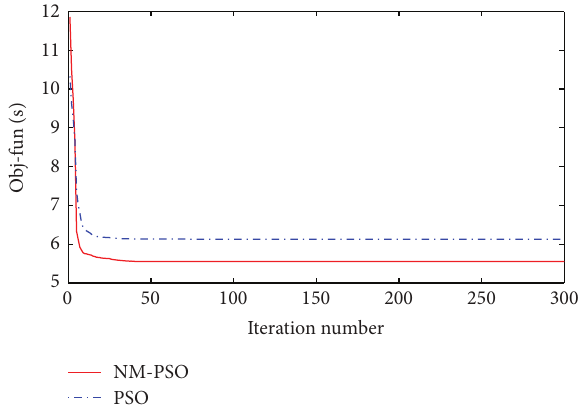
Figure 2: Convergence characteristics of a conventional PSO and the proposed NM-PSO in a fixed network